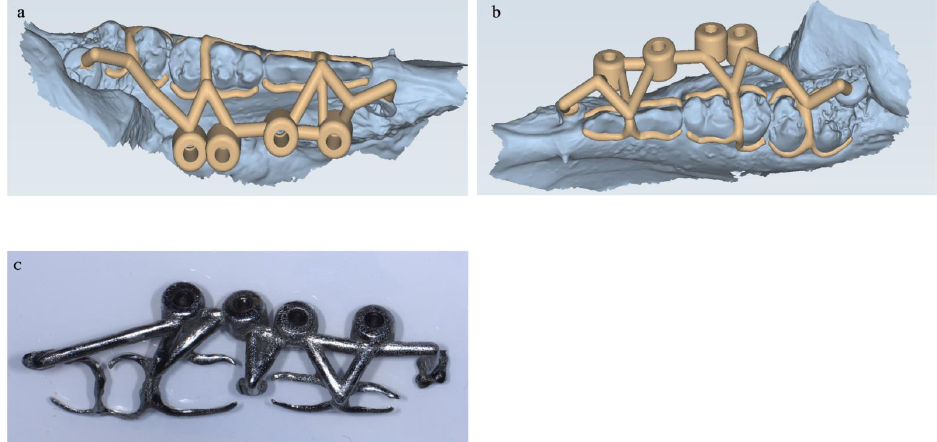
Figure 2. Planification of the 3D-printed surgical metal guide. Eight virtual surgical guides were designed using 3D implant planning software 3Shape Implant Studio. ( a ) Occluso-buccal and ( b ) occluso-lingual views showing one example of the virtual surgical guide in yellow and the optical scan of the mandible pig jaw in blue. ( c ) The different SMGs were 3D-printed in cobalt-chrome.